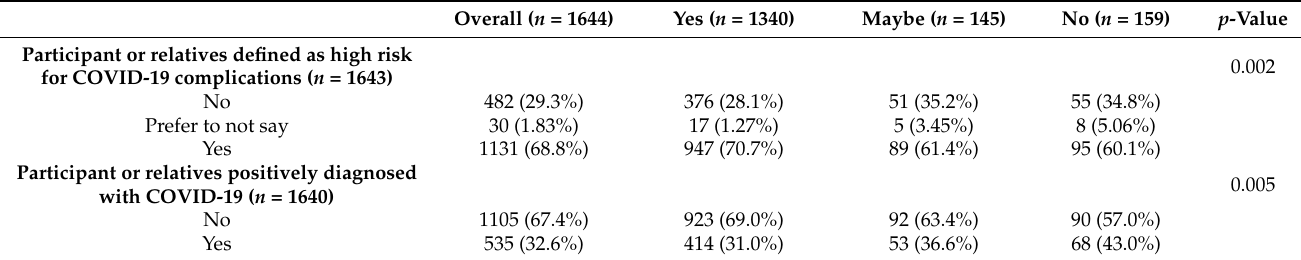
Table 3. Health status characteristics regarding COVID-19 of the participants in the